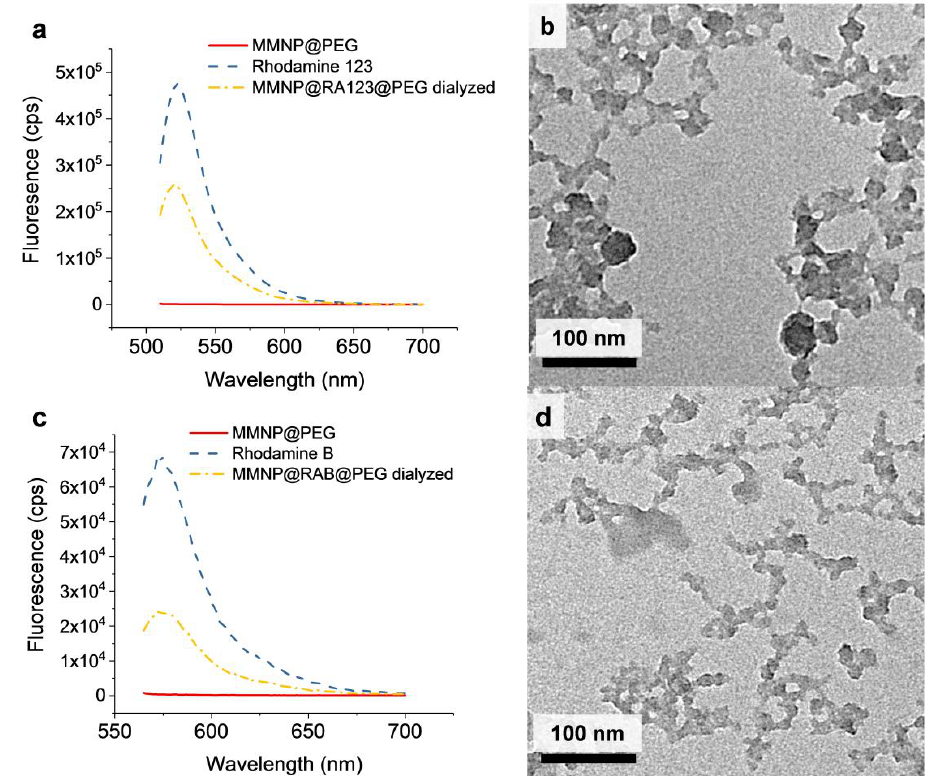
Figure 6. Fluorescence emission spectra and TEM images of in situ labeled MMNP@RA123 and MMNP@RAB. ( a ) Fluorescent emission spectra (λ ex = 500 nm) of MMNP@RA123@PEG after seven